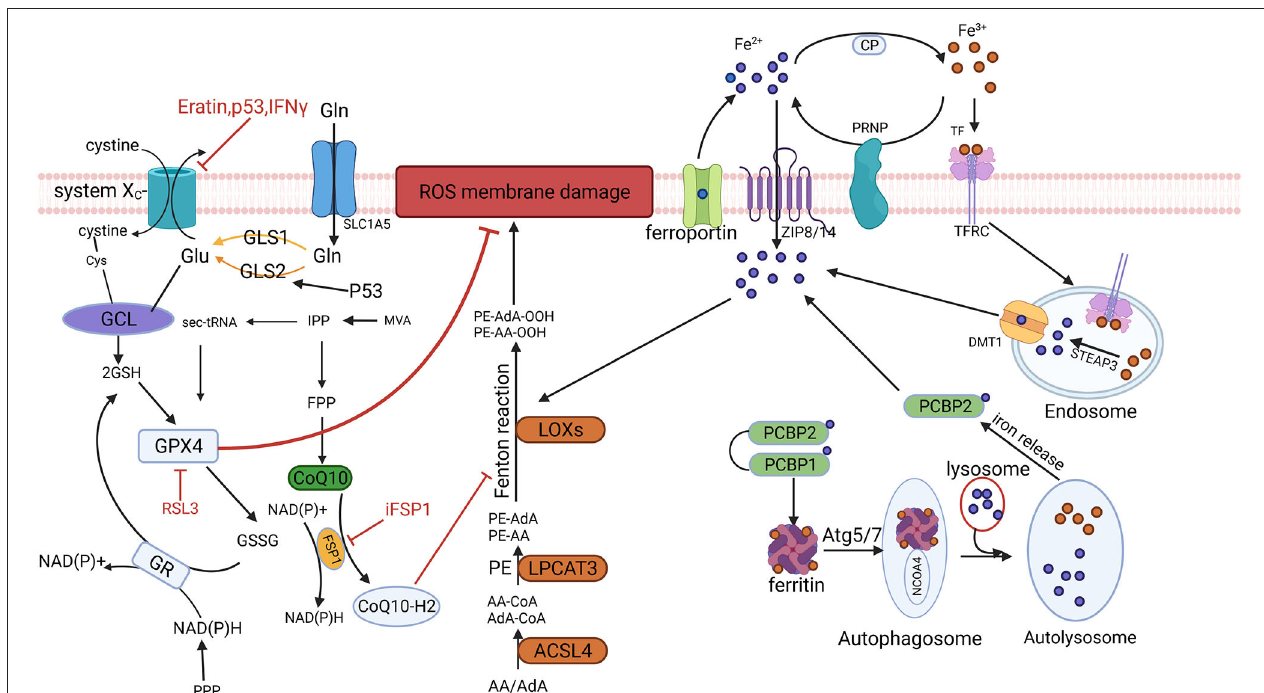
FIGURE 1 | Mechanism and regulation of ferroptosis. Reactive oxygen species (ROS)-induced membrane lipid peroxidation is a key link in ferroptosis. After the extracellular Fe 3 + is transferred into the cell, it is reduced to Fe 2 + , and the free Fe 2 + generates ROS through the Fenton reaction, which mediates the occurrence of lipid peroxidation. Cystine is transported into the cell by System Xc − and participates in the synthesis of glutathione (GSH). Glutathione peroxidase 4 (GPX4) reduces peroxidized membrane lipids using GSH as substrates. Ferroptosis inhibitory protein (FSP1) scavenges peroxidized membrane lipids and inhibits ferroptosis by reducing ubiquinone (CoQ10) to ubiquinol (CoQH2). ROS, reactive oxygen species; GSH, glutathione; GPX4, glutathione peroxidase 4; FSP1, ferroptosis inhibitory protein; CoQ10, ubiquinone; CoQH2,